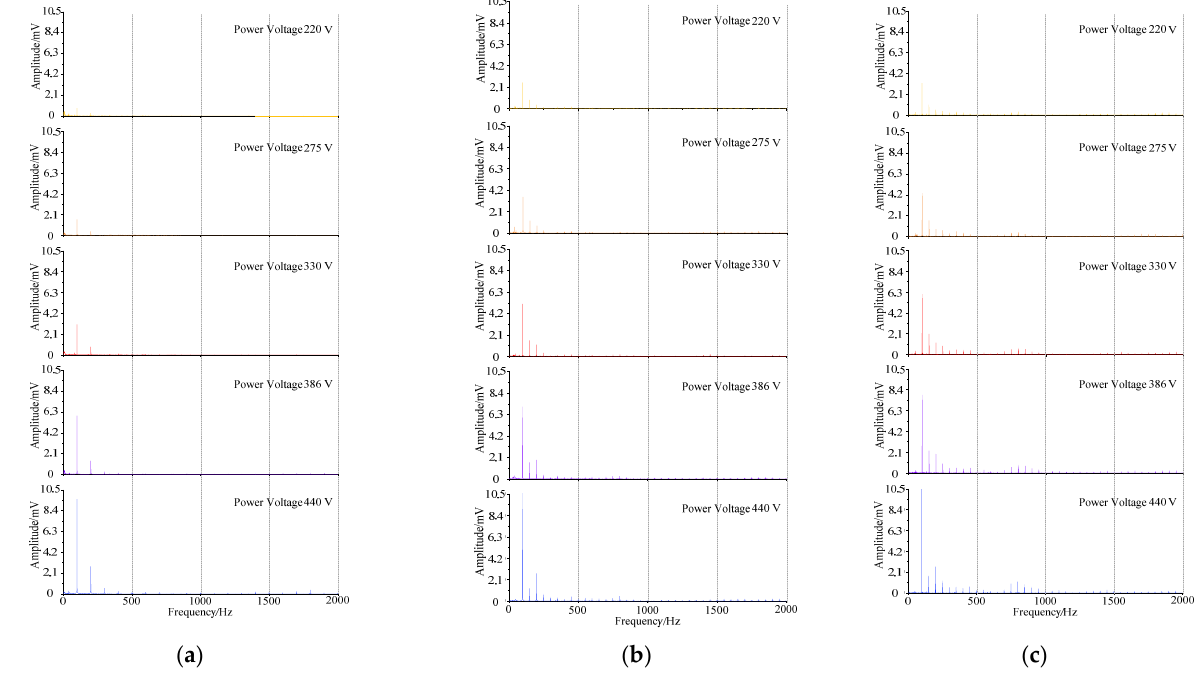
Figure 5. Transformer core model acoustic signal frequency spectrum. ( a ) Normal state. ( b ) DC bias current = 0.5 A. ( c ) DC bias current = 1.0 A.